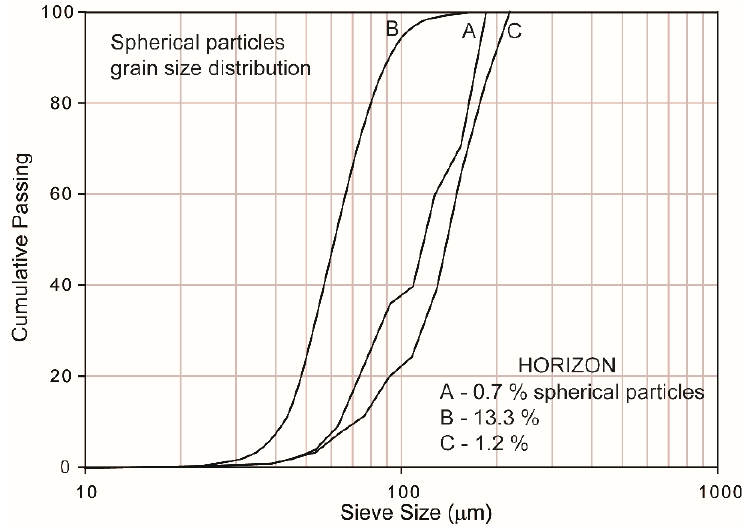
Figure 5. Grain size distribution of spherical particles in each horizon with corresponding modal proportion (% Area).